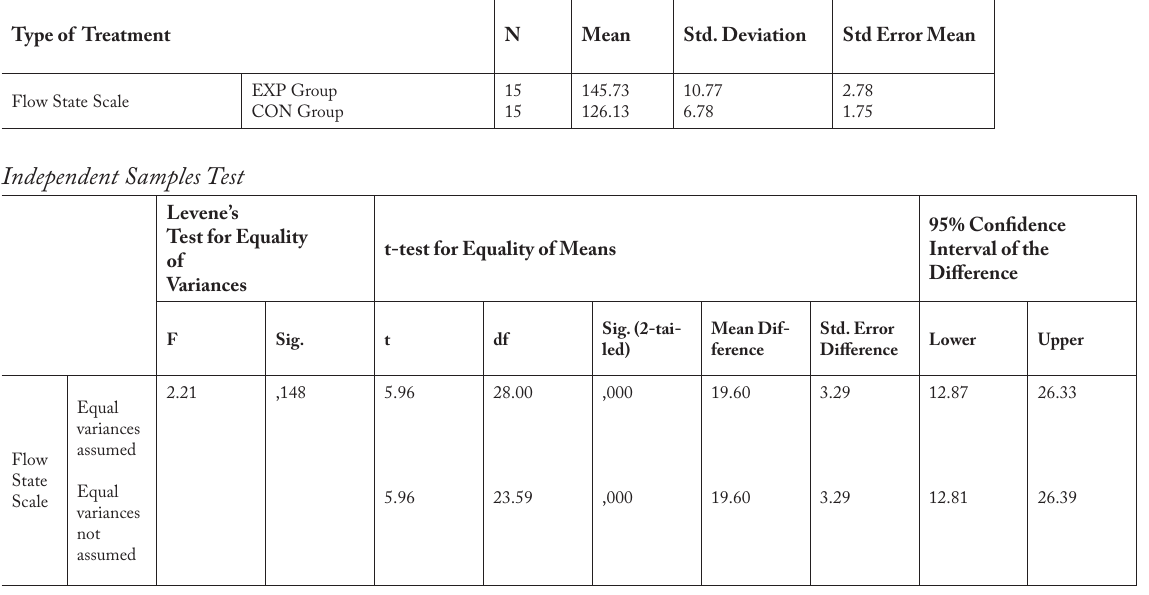
Table 1 . Difference between EXP and CON groups for flow state scores. Group Statistics